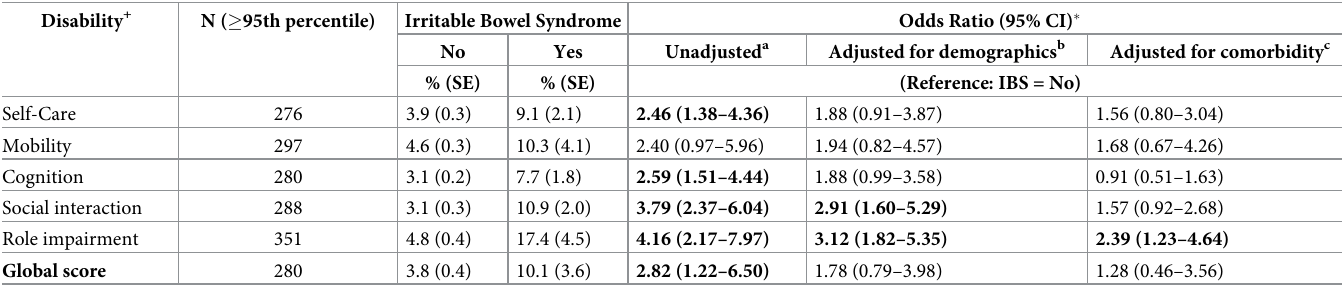
Table 5. Domain and overall scores for functional impairment (WHODAS-II) in the adult IBS cohort in NCS-R Part II survey. Disability + N ( � 95th